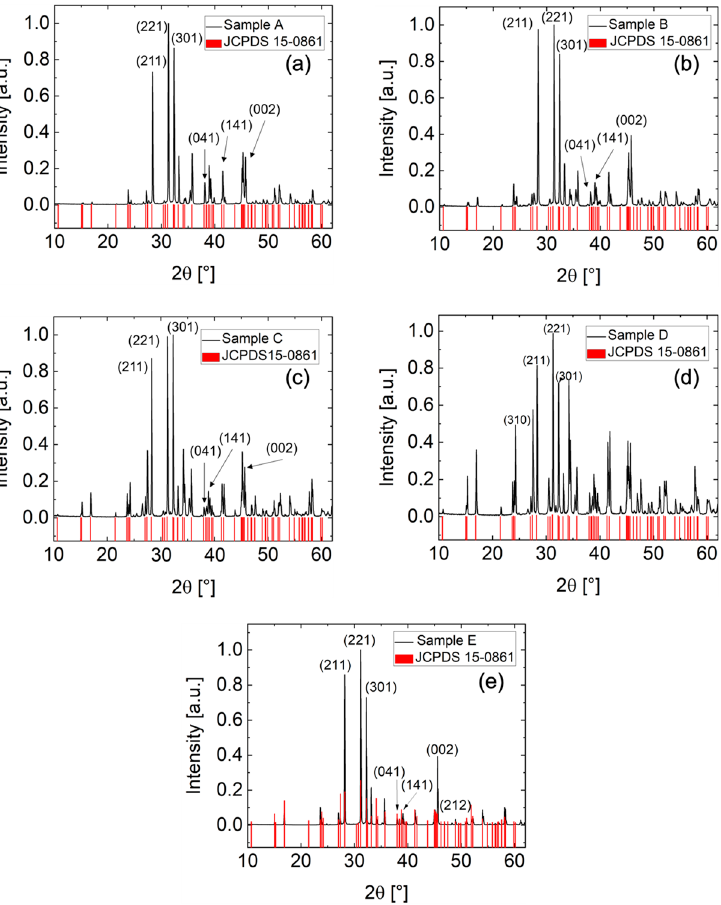
Figure 3. XRD spectra of Antimony selenide films grown on ( a ) CdS, ( b ) CdS:F, ( c ) CdSe, ( d ) As 2 S 3 and ( e ) ZnCdS.